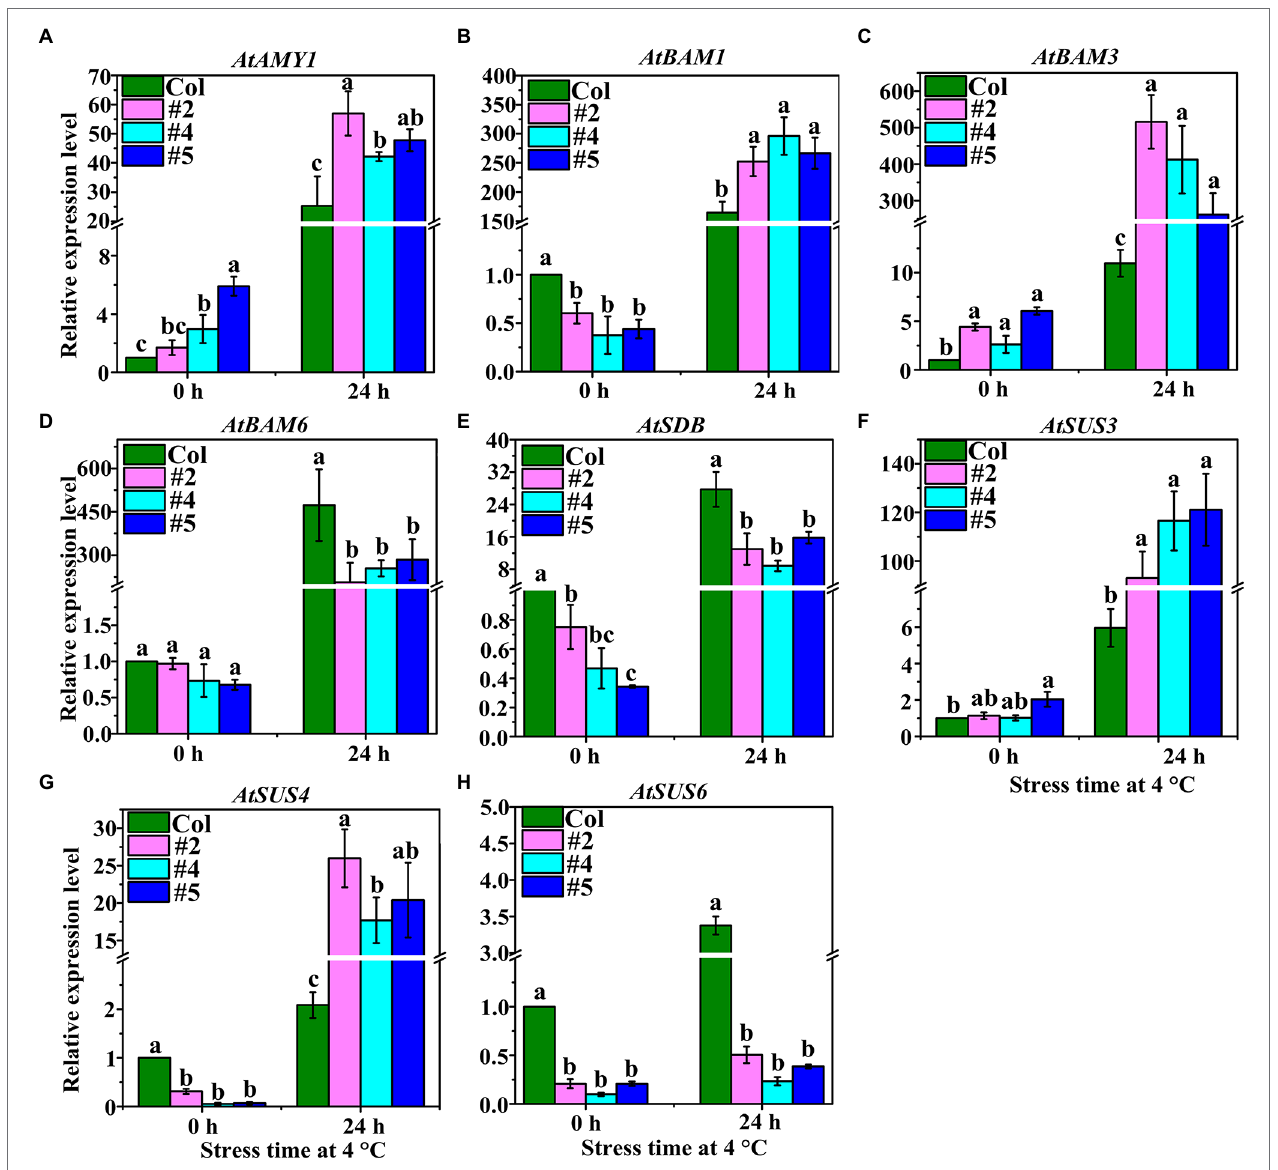
FIGURE 4 | Starch and sucrose metabolism-related genes were analyzed by qRT-PCR in Col and VaAPL1 -overexpressing A. thaliana plants at 4 ° C after 0 h and 24 h. These genes include: (A) α -amylase ( AtAMY1 ); (B–D) β -amylase ( AtBAM1 , AtBAM3 , and AtBAM6 ); (E) starch debranching enzyme ( AtSDB1 ); (F–H) SuSy ( AtSUS3 , AtSUS4, and AtSUS6